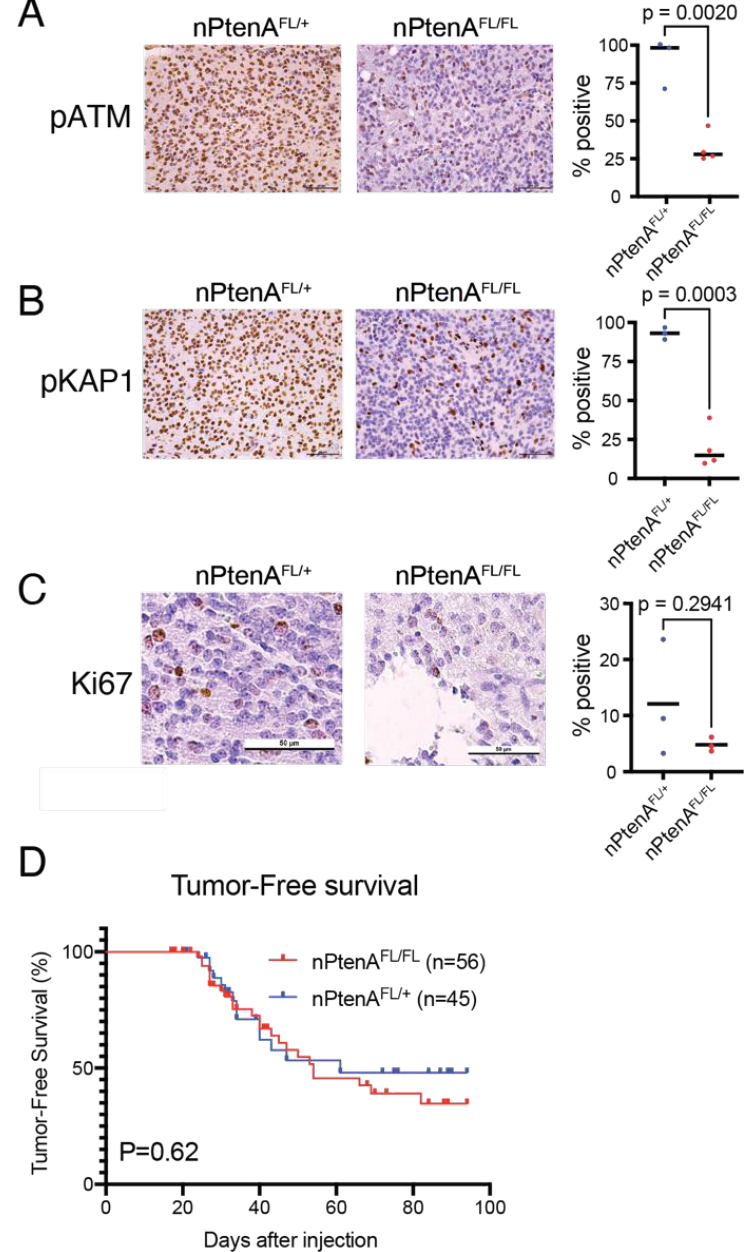
Figure 2. Effects of ATM loss on brainstem gliomas driven by Pten deletion. ( A ) Representative immunohistochemistry of phospho-Atm protein 1 h after 10 Gy focal brain irradiation in nPtenA FL/+ (n = 3) mice ( left ), as compared to nPtenA FL/FL (n = 4) mice ( right ). Cell positivity percentage is shown on the plot on the right, and Student’s t -test p -value is shown. Scale bars represent 50 µ m. ( B ) Representative immunohistochemistry of phospho-KAP1 1 h after 10 Gy focal brain irradiation in nPtenA FL/+ (n = 3) mice ( left ), as compared to nPtenA FL/FL (n = 4) mice ( right ). Cell positivity percentage is shown in the plot on the right, and Student’s t -test p -value is shown. Scale bars represent 50 µ m. ( C ) Ki67 staining in unirradiated brainstem gliomas from nPtenA FL/+ ( left ) and nPtenA FL/FL ( right ) mice. Cell positivity percentage is shown in the plot on the right, and Student’s t -test p -value is shown. Scale bar represents 50 µ m. ( D ) Tumor-free survival in the absence of irradiation in nPtenA FL/+ and nPtenA FL/FL mice. p -value is for the log-rank